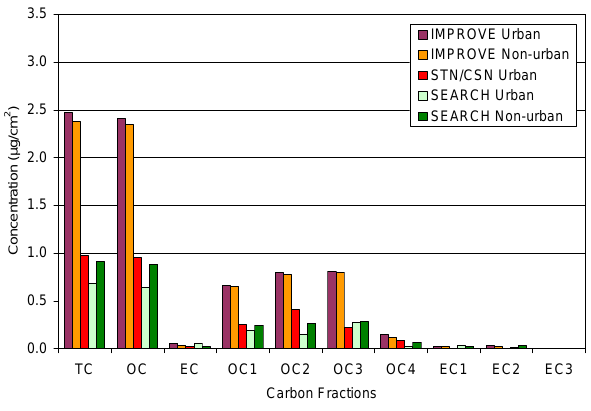
Figure 4. Fig. 4. Comparison of field blank (bQF) carbon fraction concentrations between the urban and non-urban sites among the IMPROVE, STN/CSN, and SEARCH networks for the period from 1 January 2005 to 31 December 2006. There are 11 urban and 170 non-urban IMPROVE sites, 239 STN/CSN urban sites, and four urban and four non-urban SEARCH sites. The urban IMPROVE sites are Atlanta, GA (ATLA1); Baltimore, MD